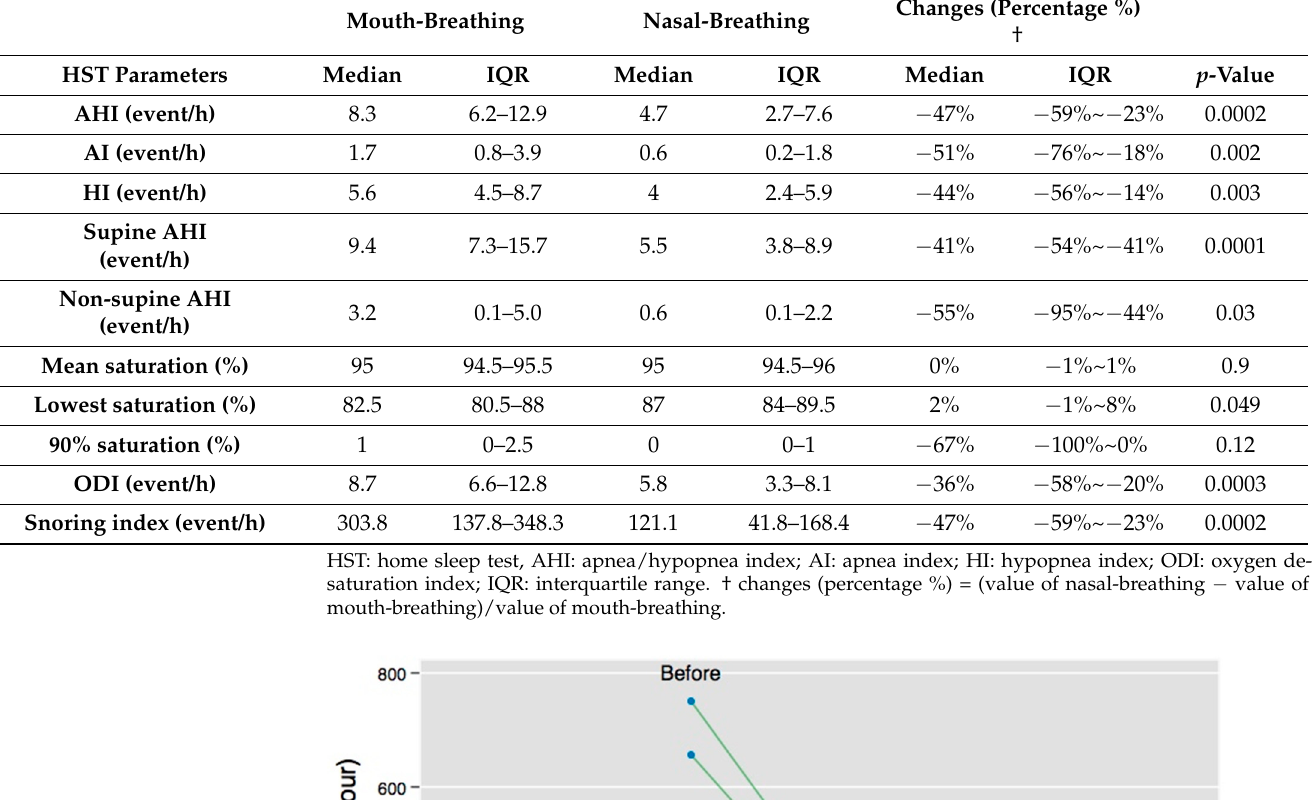
Table 2. HST data from before and after mouth-taping.